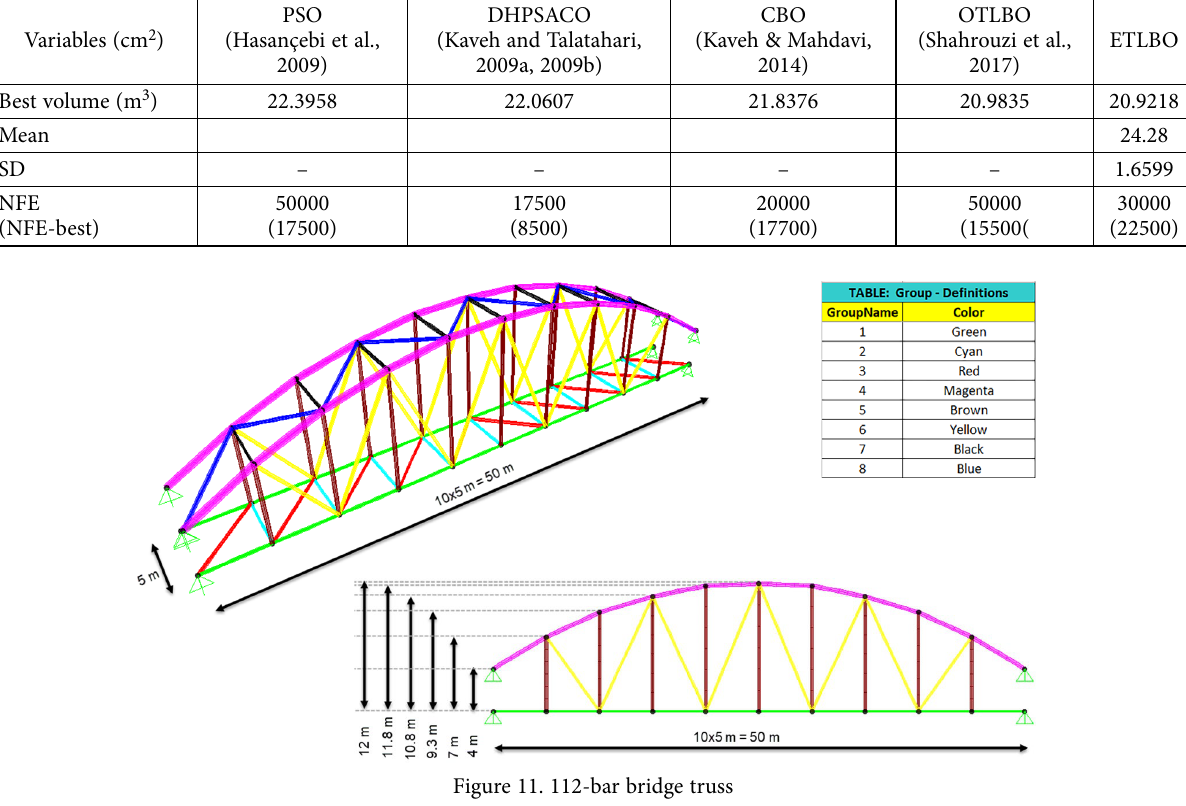
Table 6. Comparison of results algorithm in literature for the 582-bar truss example Variables (cm 2 )